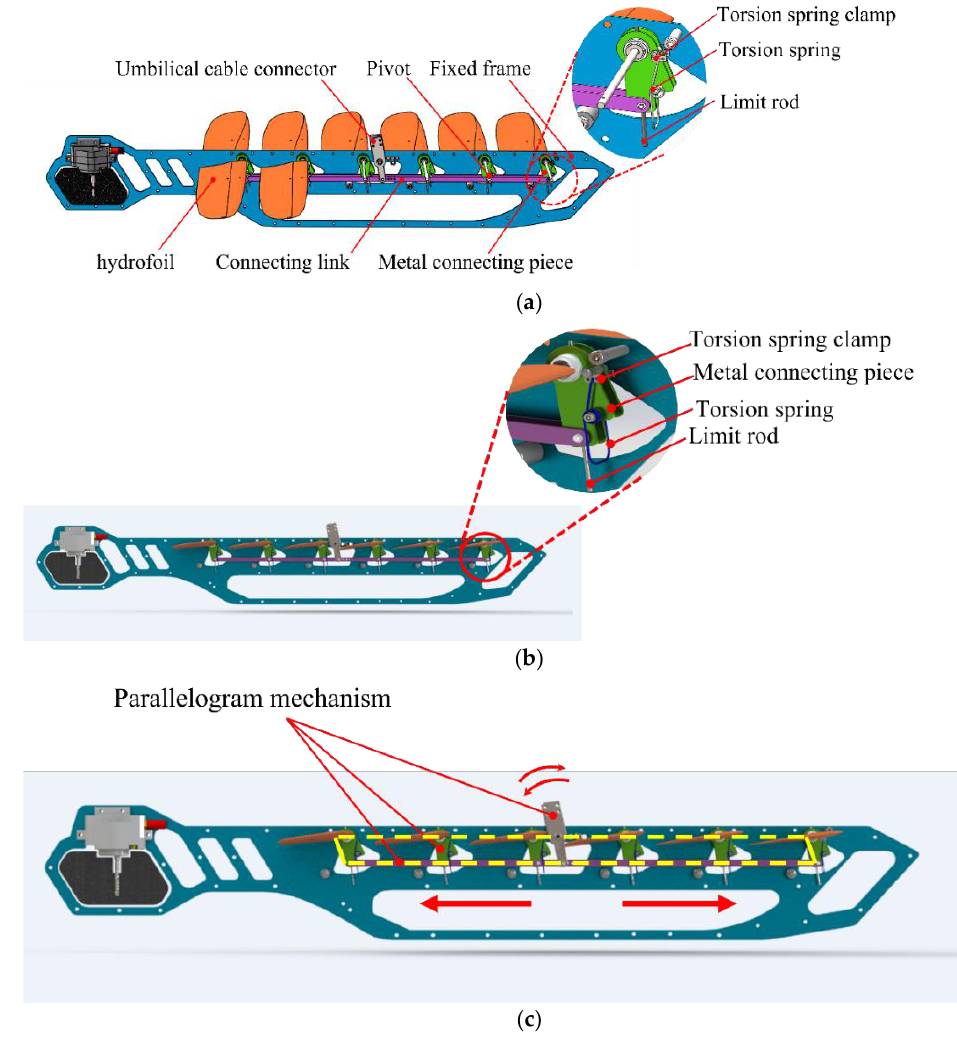
Figure 18. The structure of the SALL submerged glider. ( a ) The installation diagram of the torsion spring; ( b ) the internal structure diagram; and ( c ) the parallelogram mechanism.